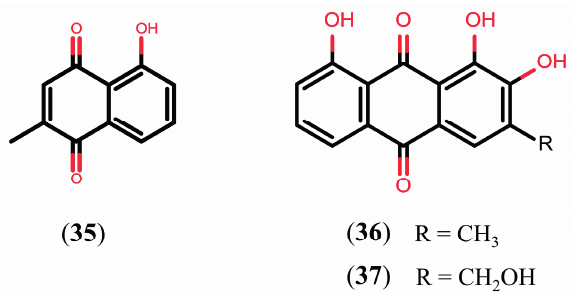
Figure 8. Chemical structures of